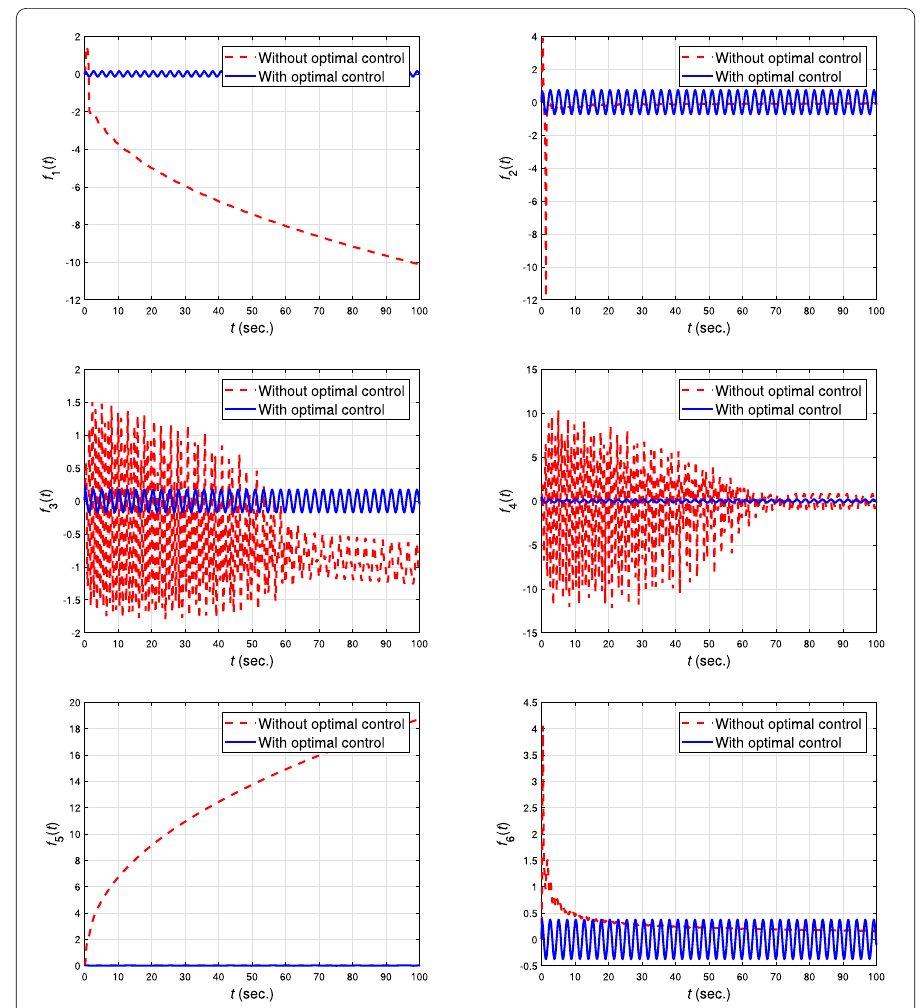
Figure 6 The state variables of the fractional-order cardiac conduction system (10) with q i = 0.9 in the absence and the presence of the proposed optimal controller